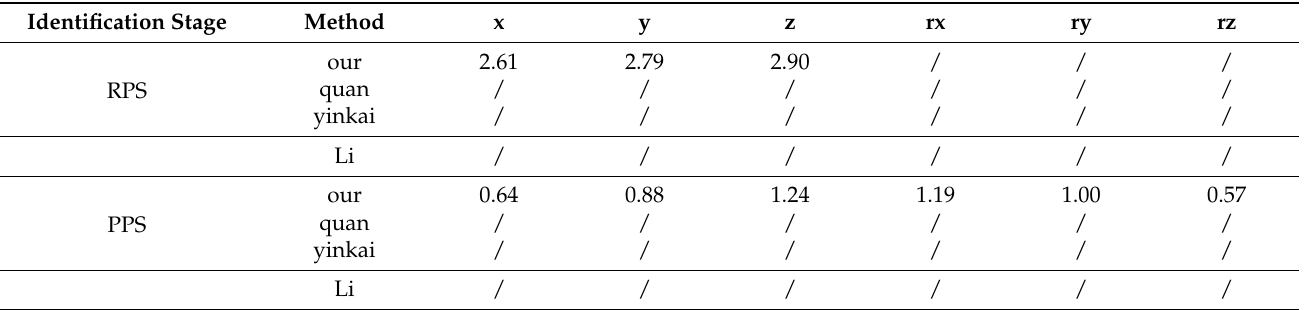
Table 8. Comparison of positioning